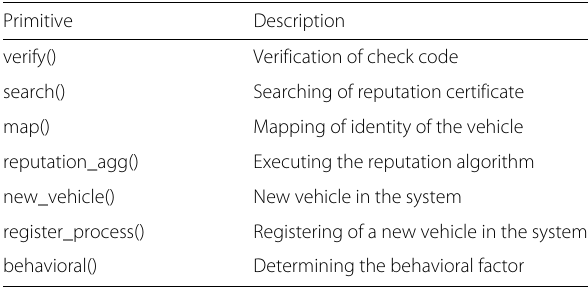
Table 4 Primitives used in the FSM of the server Primitive